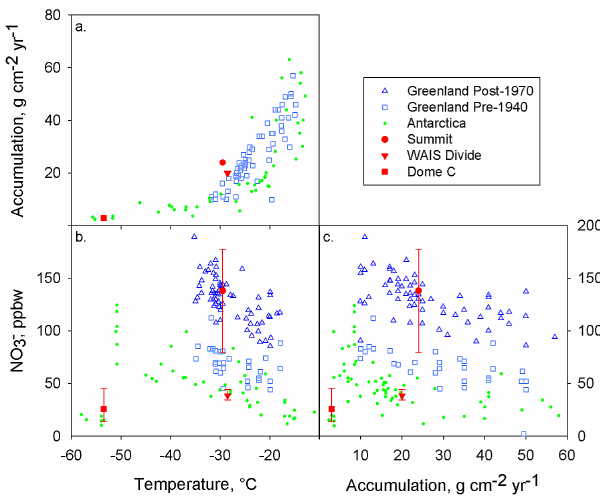
Fig. 7. Updated Figs. 2, 3 and 4 from Rothlisberger et al. (2002) with additional measurements from WAIS Divide, Summit, and Dome C (median and range). Data reported from Greenland are NO − concentrations in snow deposited either before 1940 (squares) 3 or after 1970 (triangles). The NO − levels observed in the snow de- 3 posited after 1970 over Greenland are influenced by anthropogenic emissions that do not reach the Antarctic continent, whereas the difference between the pre-1940s records and the Antarctic data is likely due to a difference in